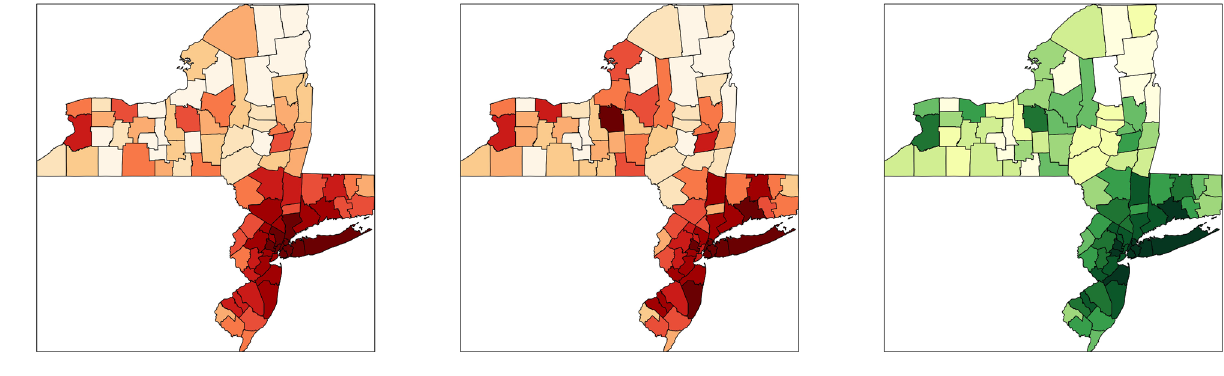
Figure 4. Spatial distributions of estimated infection prevalence and observed new COVID-19 cases in the New York Tri-State Area in the week ending 12 April 2020. Top twenty counties for likely intervention in the order of their rank (by CPM × active cases): Queens County, Kings County, Nassau County, Suffolk County, Essex County, Bronx County, New Haven County, New York County, Monmouth County, Union County, Westchester County, Bergen County, Middlesex County, Ocean County, Fairfield County, Hudson County, Dutchess County, Camden County, Mercer County, and Richmond